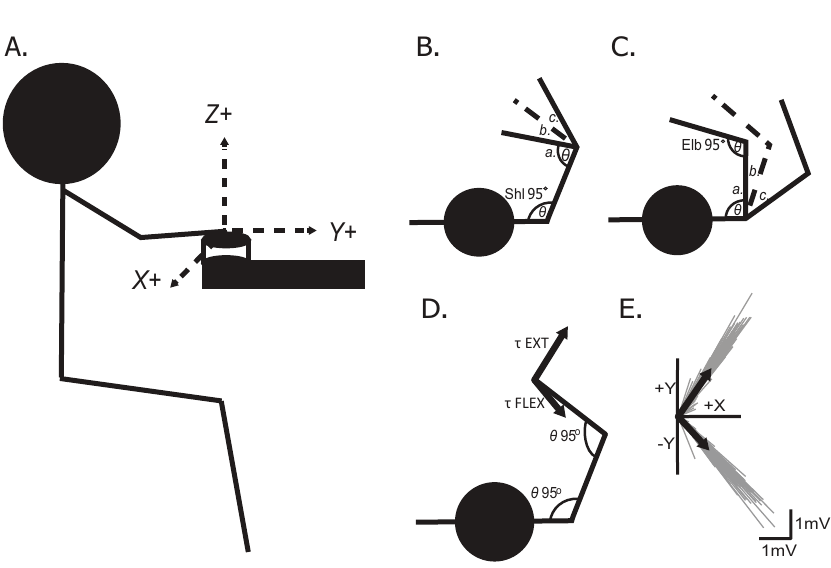
Figure 1. Schematic showing the joint configurations and details of the practice task. A ) Sagittal view of the subject with the wrist secured to the force transducer and the orientation of the forces recorded for all of the experiments. B ) When independently changing elbow angle (a. ELBFLEX; b. NEUT; c. ELBEXT) while keeping the same shoulder angle ( θ = 95°); and C ) When independently changing shoulder angle (a. SHLFLEX; b. NEUT; c. SHLEXT) while keeping the same elbow angle ( θ = 95°). Note that the dashed line (b.) in both B and C is the same NEUT condition and was only tested once during the trials and also again after all of the joint positions had been completed. D ) Schematic showing the joint configuration ( τ = elbow ~95°, shoulder ~95°) for both EXT and FLEX practice protocols. E ) Representative data from one subject demonstrating the magnitude and direction of the endpoint force vector from the nociceptive withdrawal response, after practice, from the individual trials (gray-thin lines) and the average responses (black-thick lines) in the (+/-)Y and +X directions. The average responses from the EXT and FLEX trials are also superimposed on panel